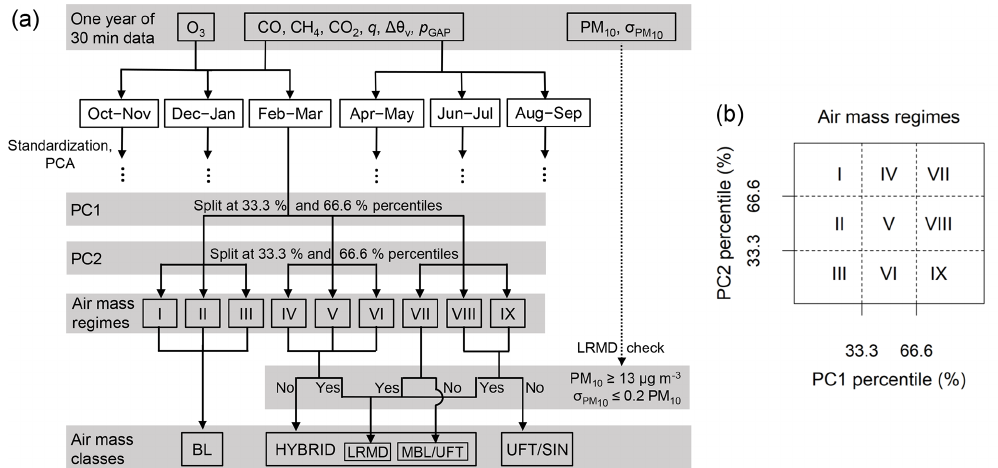
Figure 3. (a) Scheme for statistical air mass classification at UFS using the first (PC1) and second principal components (PC2) of a 6- or 7-dimensional data set. The mapping of air mass regimes to air mass classes is only shown for February and March and was different for other 2-month periods. BL denotes recent contact with the boundary layer, UFT/SIN includes the undisturbed free troposphere and stratospheric intrusions, and HYBRID reflects influences from both BL and UFT/SIN and includes the LRMD (long-range transport of mineral dust) and MBL/UFT (influence of the marine boundary layer or UFT) subclasses. (b) Numbering of the air mass